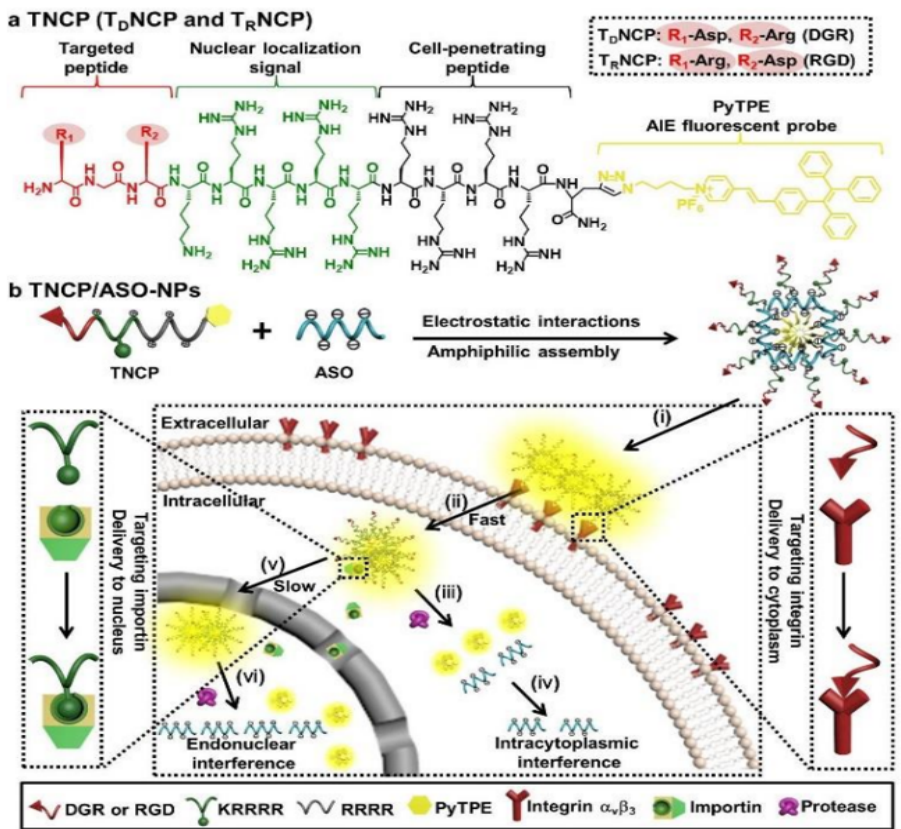
Figure 26. Illustration of TNCP and TNCP/ASO self-assembled nanoparticles (TNCP/ASO-NPs). ( a ) Molecular structure of TNCP including T D NCP and T R NCP. ( b ) TNCP/ASO-NPs are used for real-time tracking the efficient and sequential targeted delivery into the nucleus. ( i ) Selective bind to integrin α v β 3 ; ( ii ) rapid entry into the cytoplasm; ( iii ) partially degraded by protease and disassembly in the cytoplasm; ( iv ) partial ASO released into the cytoplasm and performed intracytoplasmic interference; ( v ) selective combination with importin and transported into the nucleus; ( vi ) most of ASO released in the nucleus and performed endonuclear interference. Reproduced from [84] with permission from John Wiley and Sons, Copyright